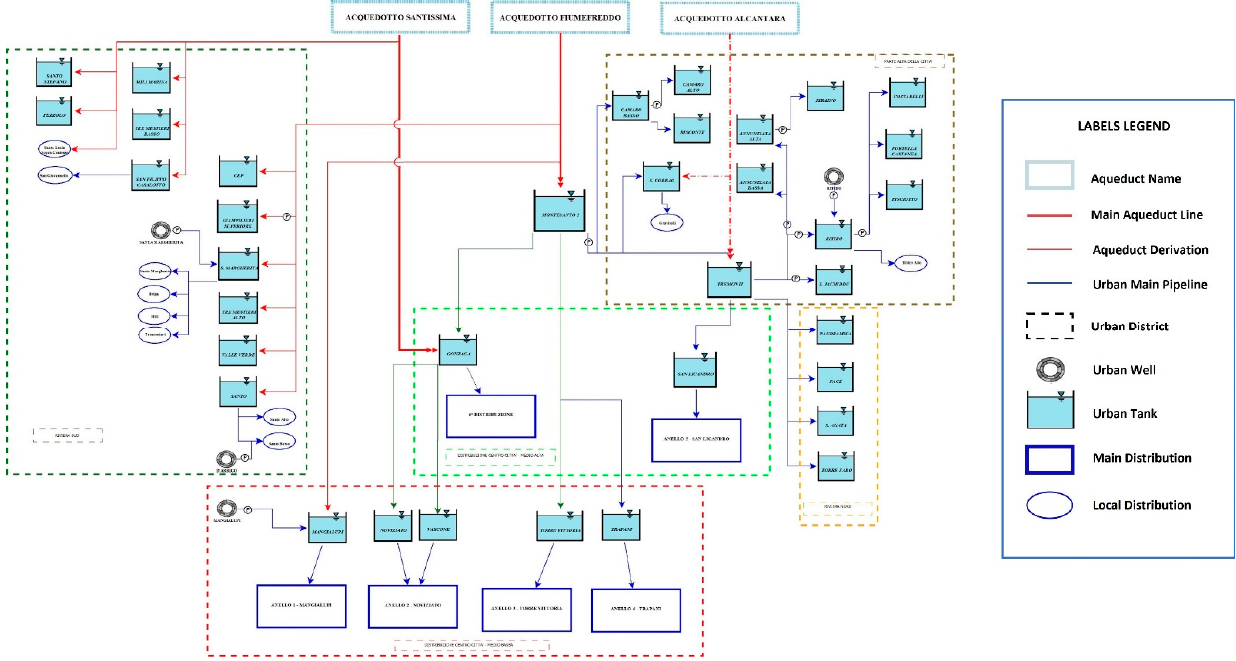
Figure 1. Scheme of the water distribution system of Messina City (excerpted from